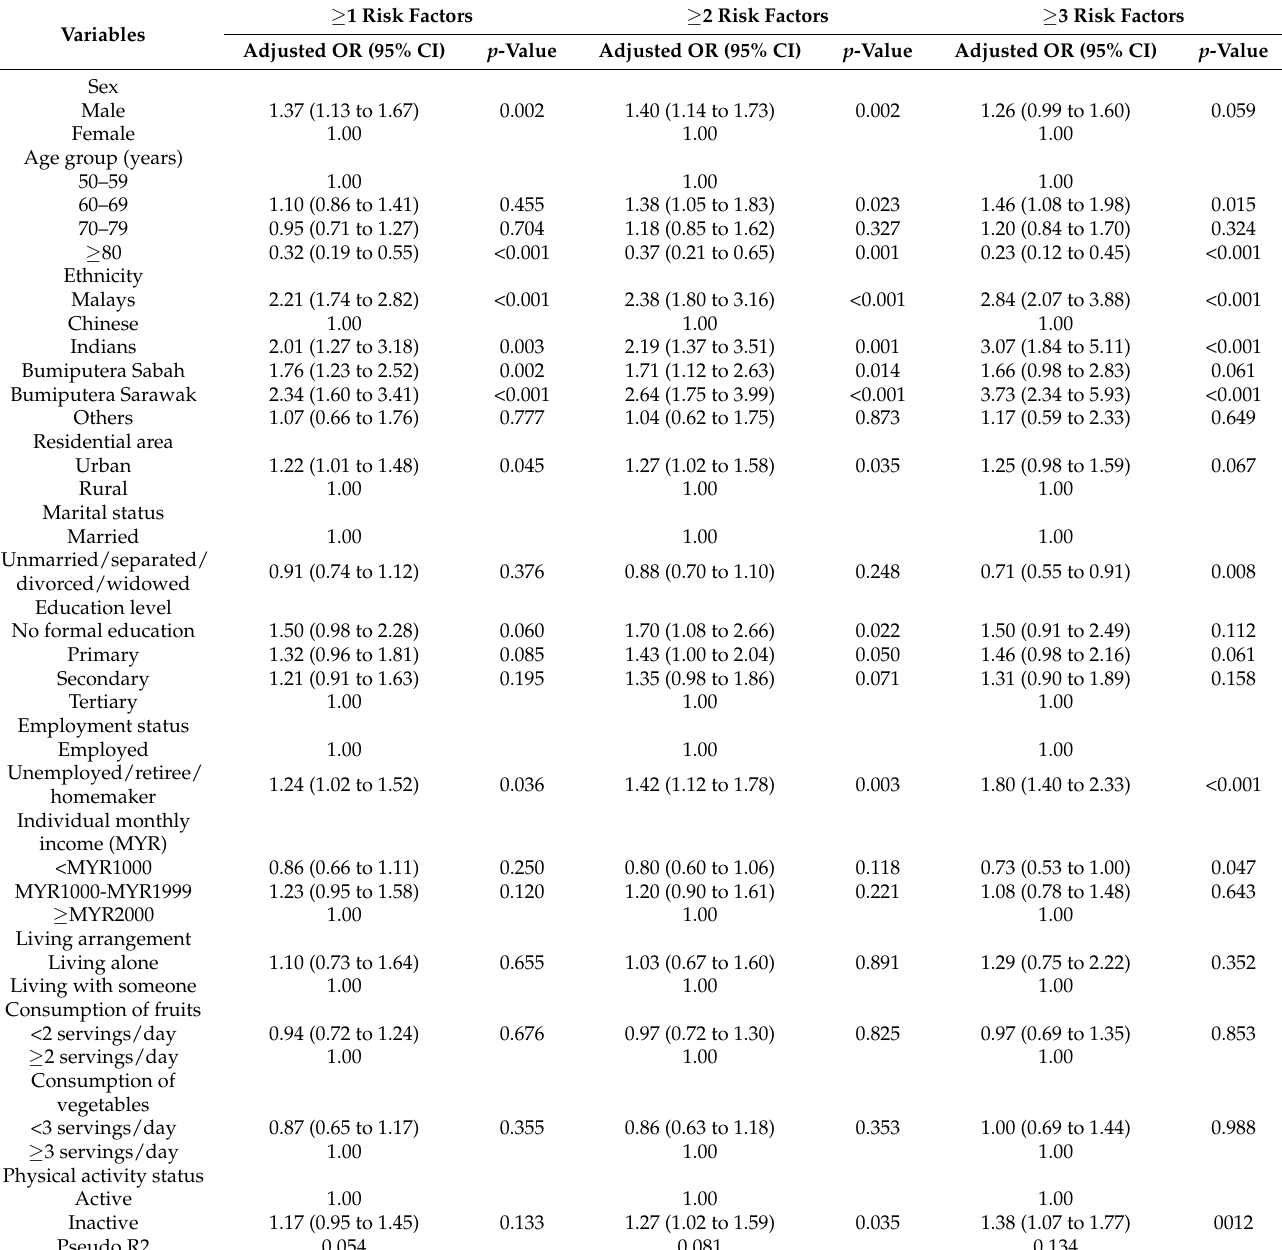
Table 4. Adjusted odds ratio (OR) and 95% confidence interval (CI) of the modifiable cardiovascular disease risk factor clustering among older